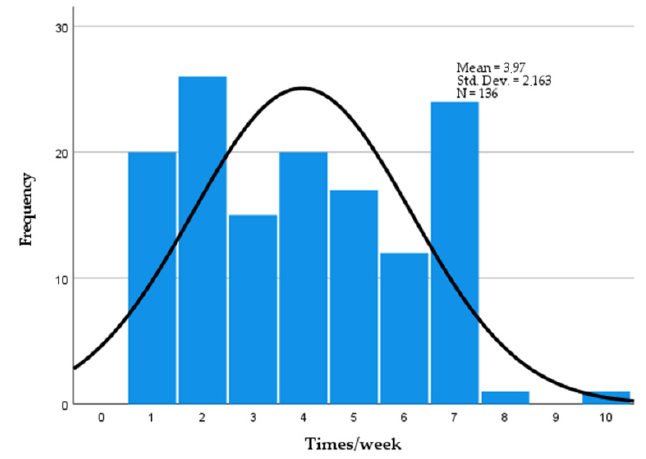
Figure 1. Pork consumption per week.